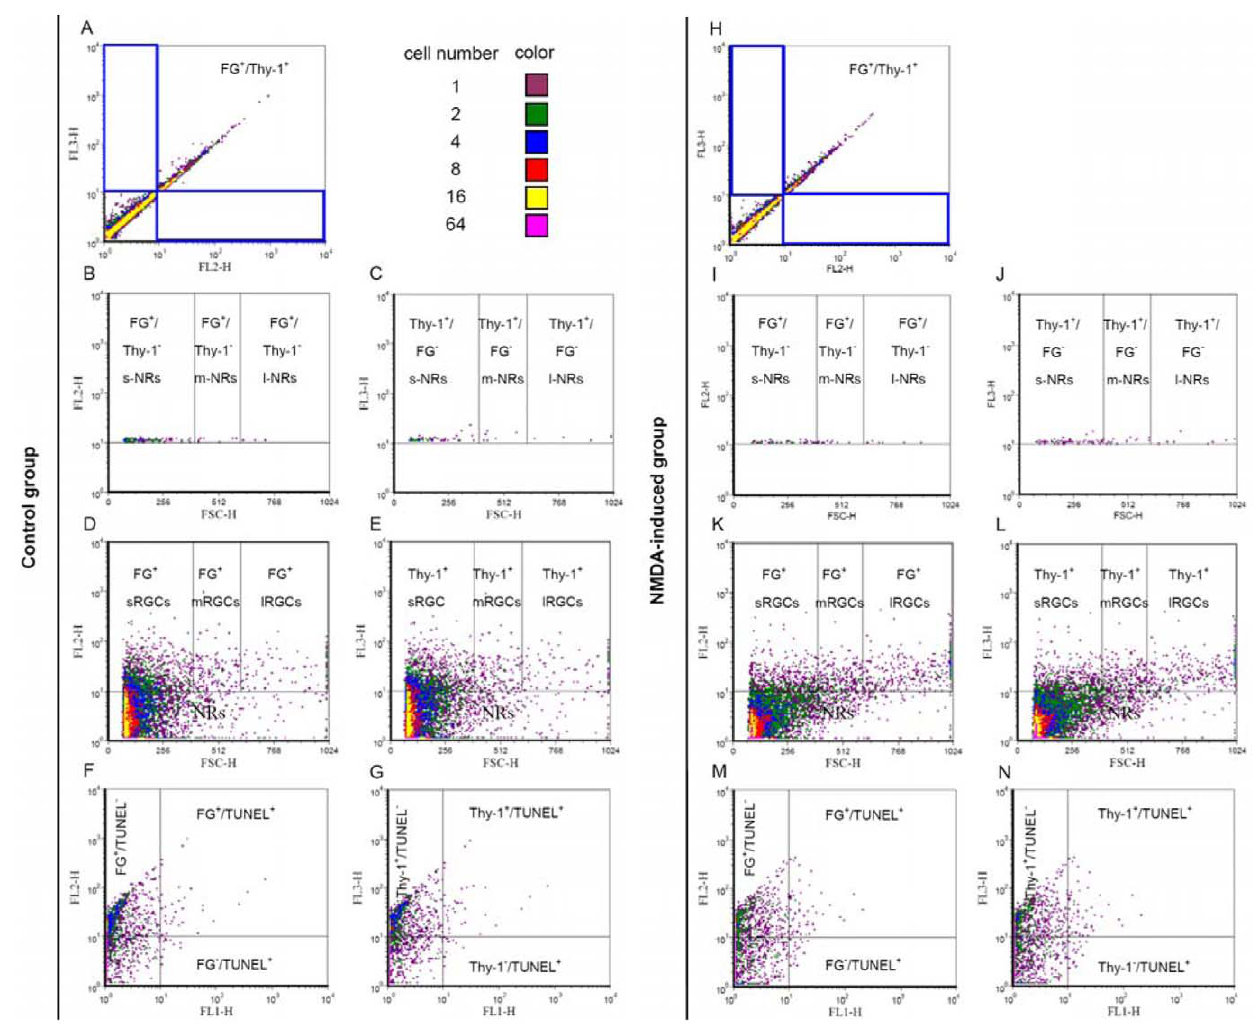
Figure 6. Flow cytometric analysis of triple-labeled retinal cells. Representative flow cytometric dot plots of triple-labeled (TUNEL, FG, and thy-1) cells of control group (A–G) and NMDA-induced group (H–N). RGCs and non-RGCs were evaluated by FG vs thy-1 labelings (A, H). Size of gated FG + /thy-1 2 (gate 1) and FG 2 /thy-1 + (gate 2) cells were evaluated by FSC vs FG labeling (B, I) and FSC vs thy-1 labeling (C, J), respectively. Small, medium and large RGCs were evaluated by FSC vs FG labeling (D, K) and FSC vs thy-1 labeling (E, L). Apoptotic RGCs were evaluated by TUNEL vs FG labelings (F, M) and TUNEL vs thy-1 labelings (G, N). Abbreviations: FL1-H=TUNEL; FL2-H=Fluoro-Gold; FL3-H=Thy-1; FSC-H=Forward scatter; s-, m- and l-NRs=small, medium and large non-RGCs; s-, m- and l-RGCs=small, medium and large